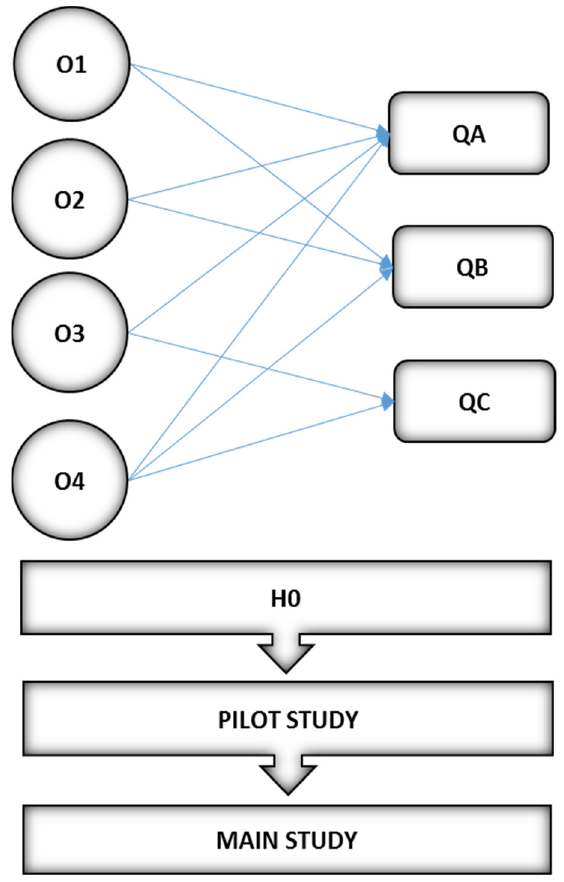
Figure 3. Research